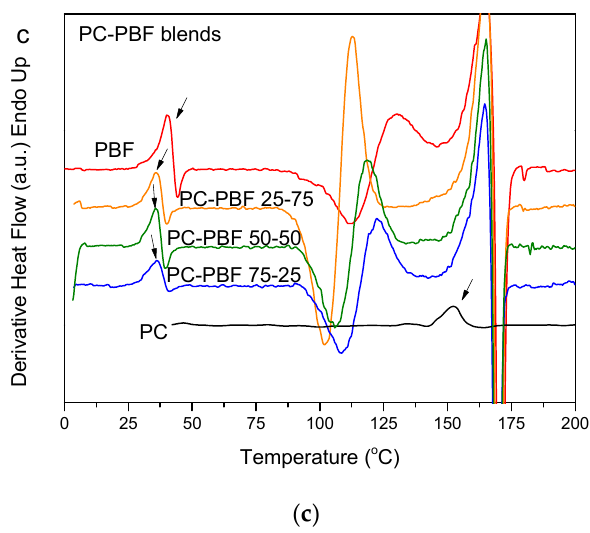
Figure 7. ( a ) WAXD patterns, ( b ) DSC traces of the melt-quenched samples upon heating, and ( c ) derivative heat flow for the polycarbonate (PC)–PBF blends.